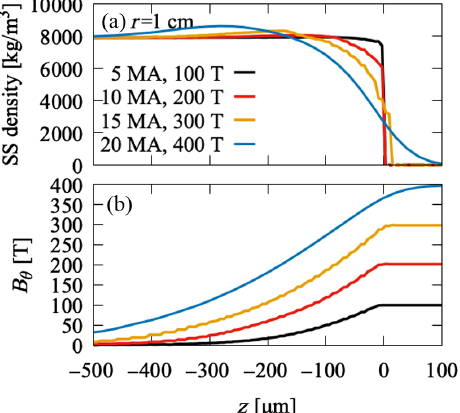
FIG. 12. The electrode (a) density and (b) magnetic field at r ¼ 1 cm for the radial transmission line in Fig. 11. The values are plotted at 4 times during the pulse corresponding to B ¼ 100 , 200, 300, and 400 θ